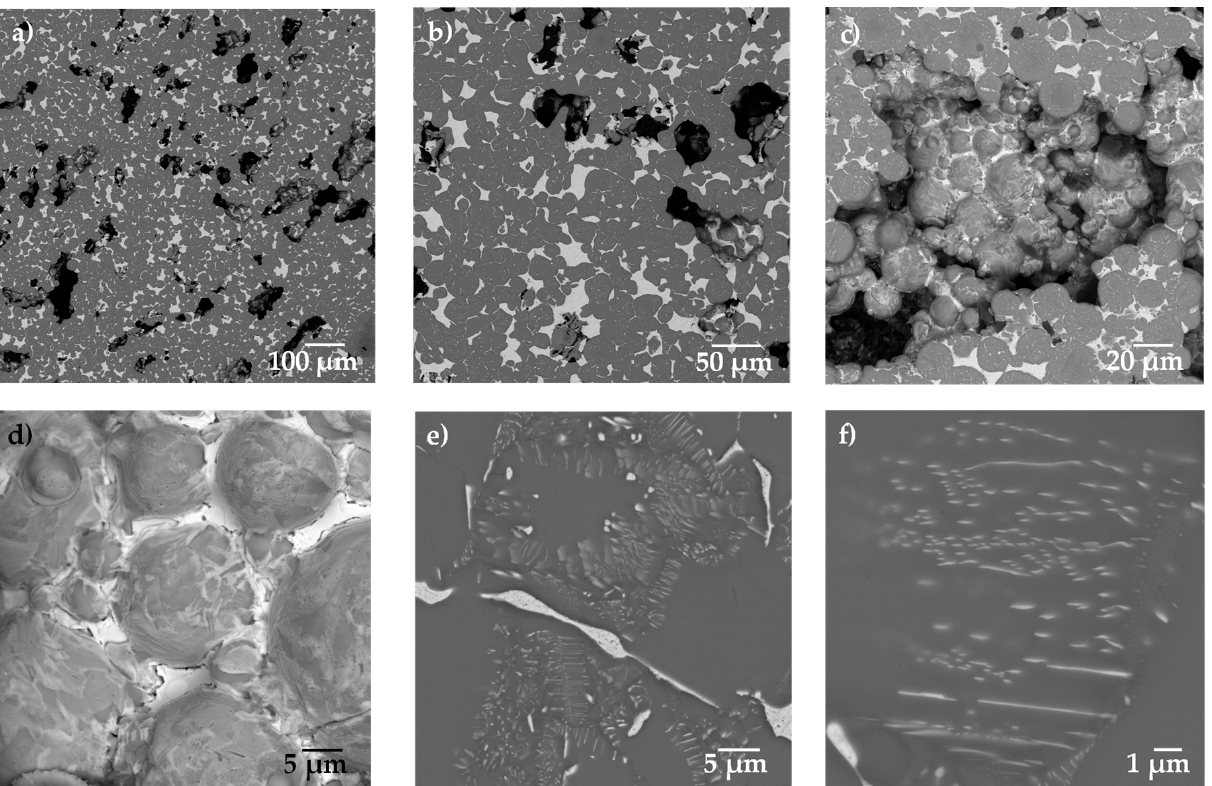
Figure 2. Backscattered electron image of the Ti64/20Ag sample with 30 vol.% of pore formers at different magnifications: ( a ) 200x, ( b ) 500x, ( c ) 1000x, ( d ) 2000x, ( e ) 5000x and ( f ) 10,000x.